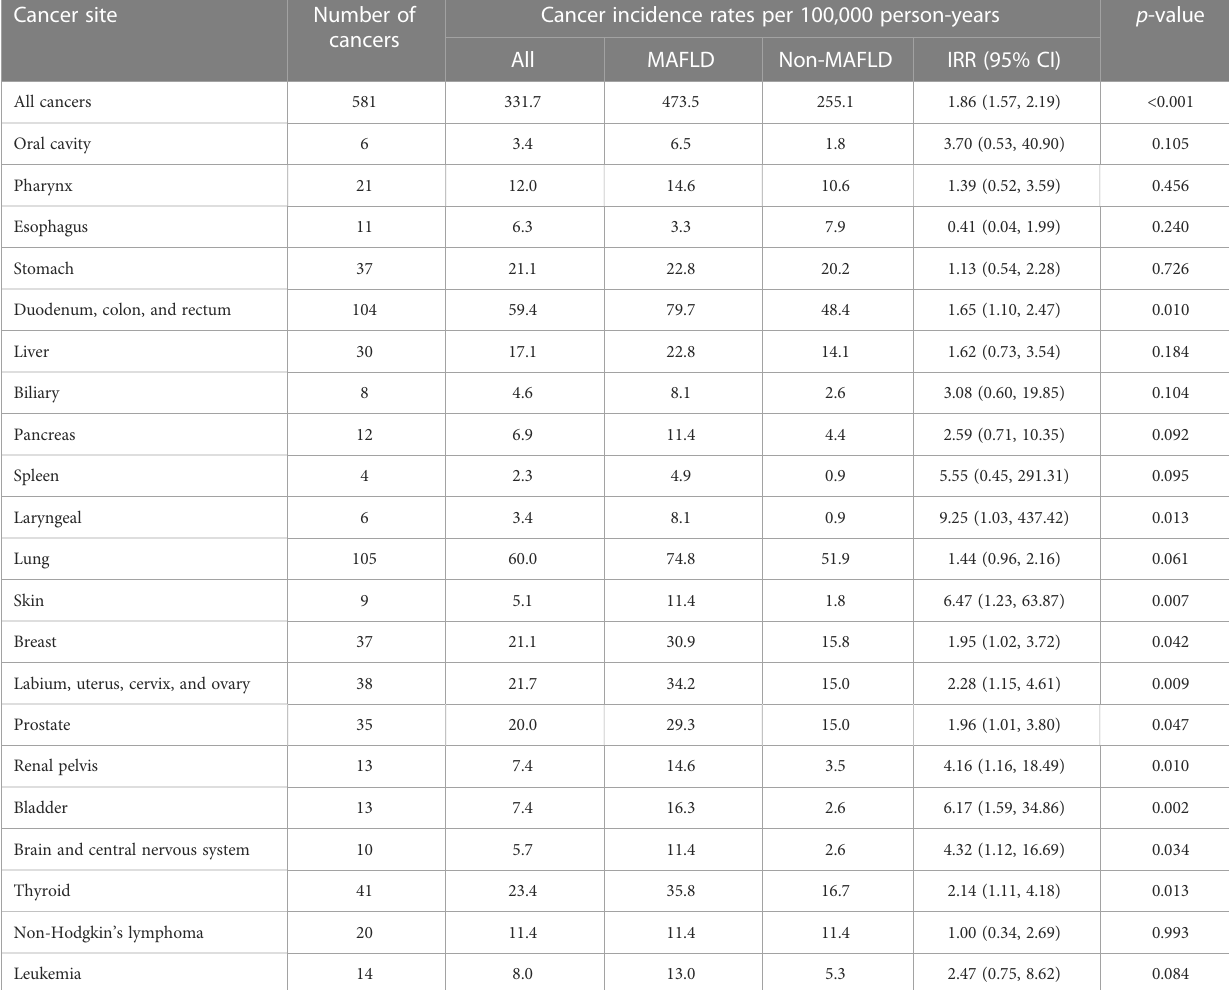
TABLE 2 Cancer incidence rates in participants with and without MAFLD. Cancer site Number of Cancer incidence rates per 100,000 cancers